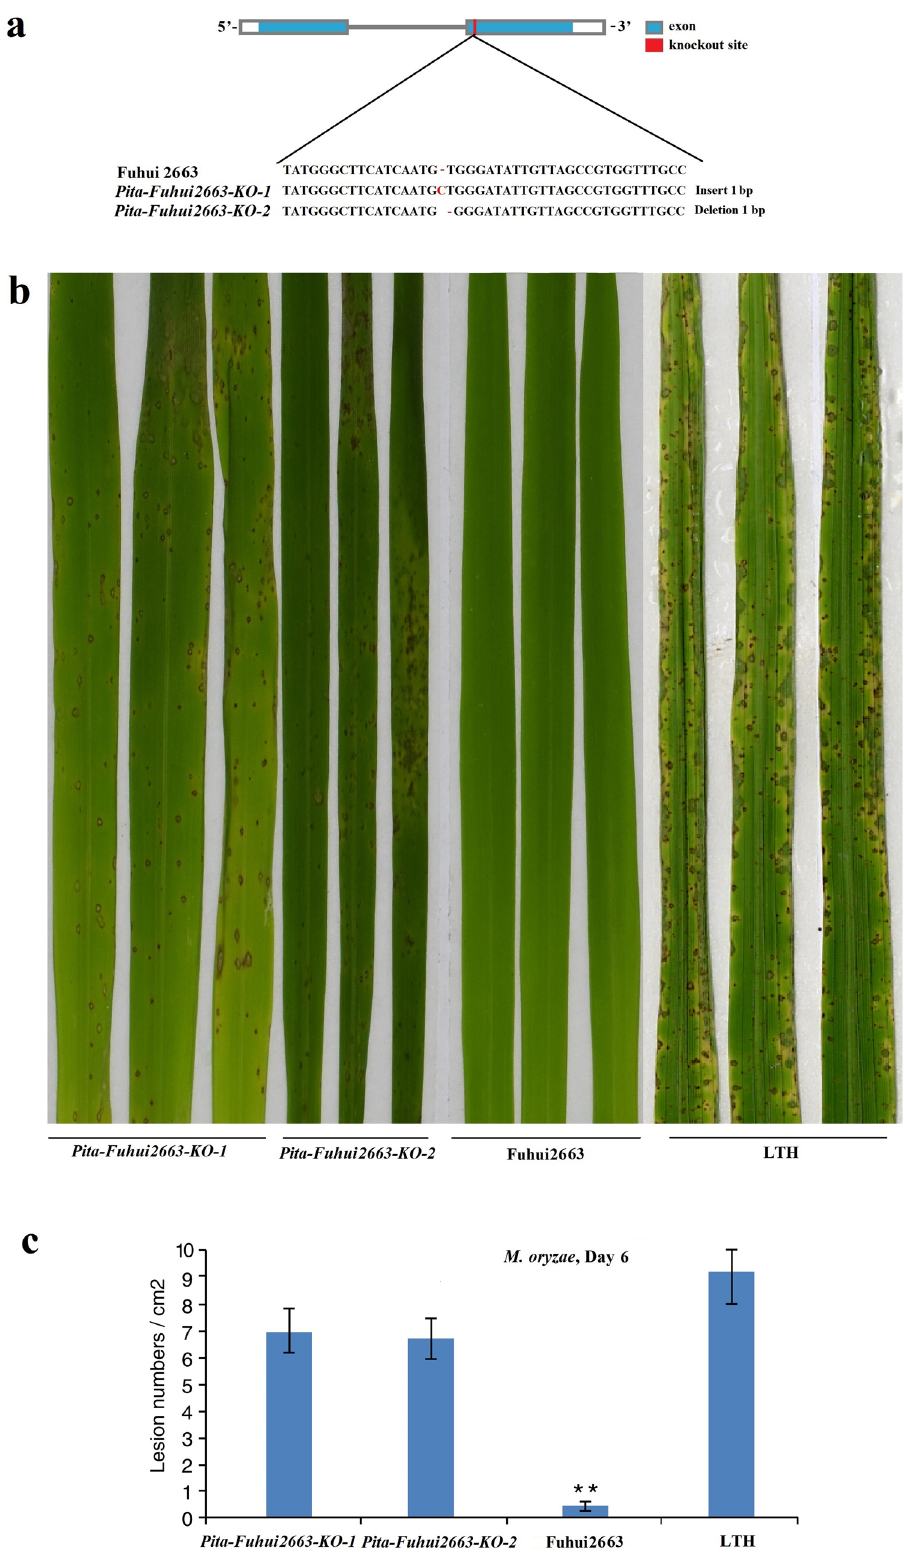
Figure 5. Pita-Fuhui2663 knockout lines showed enhanced susceptibility to KJ201. ( a ) Two independent lines (designated Pita-Fuhui2663-KO-1 and Pita-Fuhui2663-KO-2 ) were generated using the CRISPR/Cas9 system and verified by sequencing. ( b ) Inoculation of rice blast fungus showed that the two knockout lines generated by CRISPR/Cas9 were susceptible to KJ201, while their parent Fuhui2663 was resistant to KJ201. Leaves were photographed 6 days post-infection with M. oryzae isolate KJ201. ( c ) Lesion numbers per cm 2 on the rice leaves (M ± SD, n > 6 leaves) after inoculation with blast fungus as in ( b ). **denotes P <